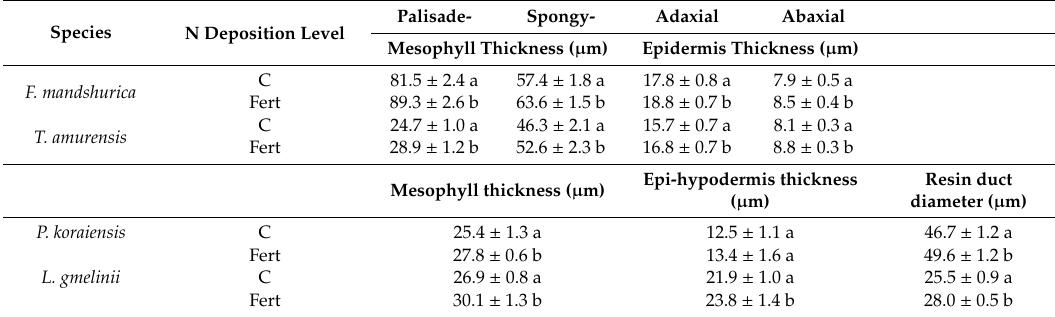
Table 2. Anatomical traits of mature, sun-exposed leaves / needles of two-year-old seedlings of Fraxinus mandshurica , Tilia amurensis (angiosperms), Pinus koraiensis and Larix gmelinii (gymnosperms) at control (C; no additional nitrogen (N) deposition) and after 10 g N m − 2 yr − 1 (Fert) additional N deposition in NE China. Palisade- Species N Deposition Level